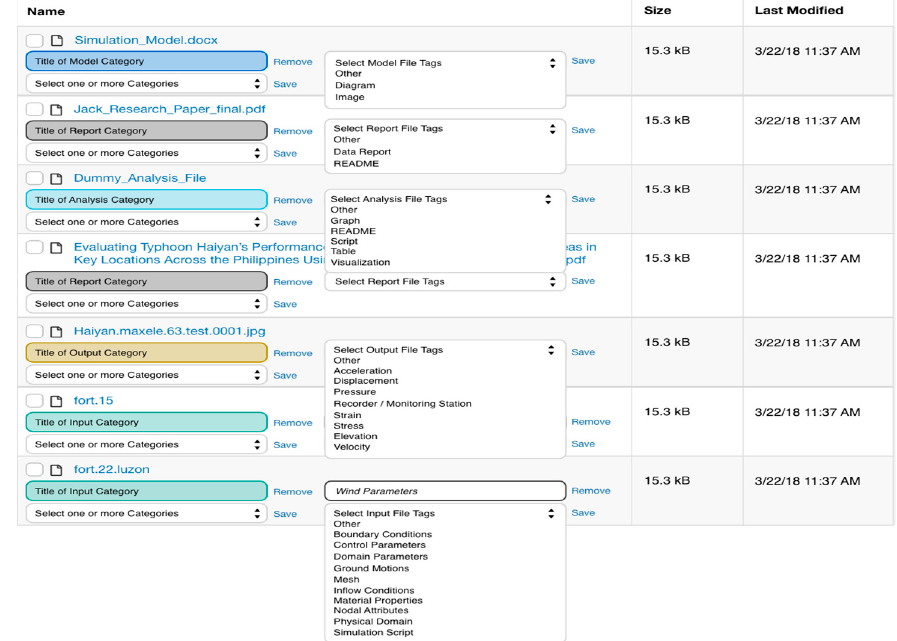
Figure 5. Curation overlay with colors, shortcuts, and menus to facilitate organizing and describing one to many files at a time. In this step, users can add files to categories and select or create terms to